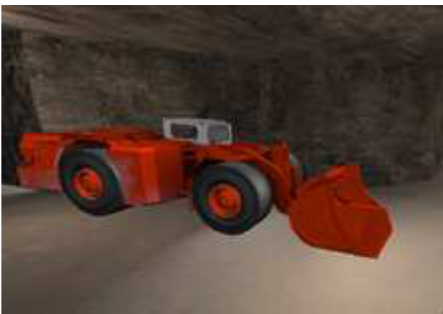
Figure 6: A screenshot from the MBD simulator de- picting a virtual mine loader in a virtual